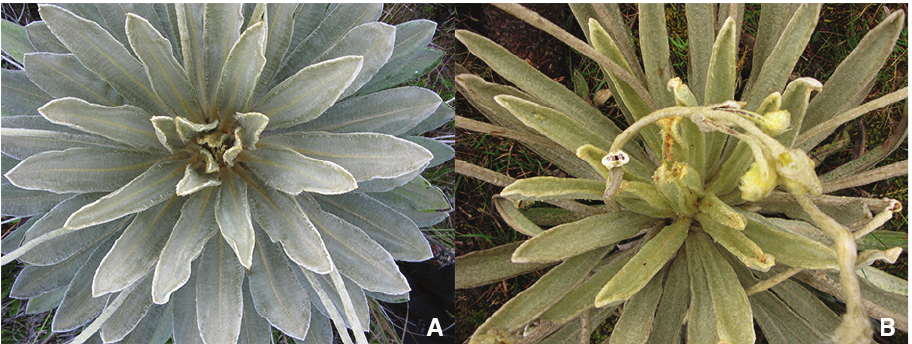
Figure 5. Comparison of rosette colours. A E. dugandii B E. praesidentis